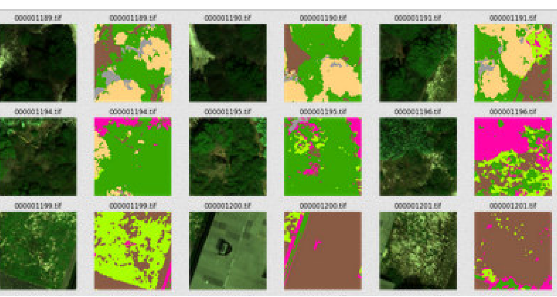
Figure 9: JILONA South training data